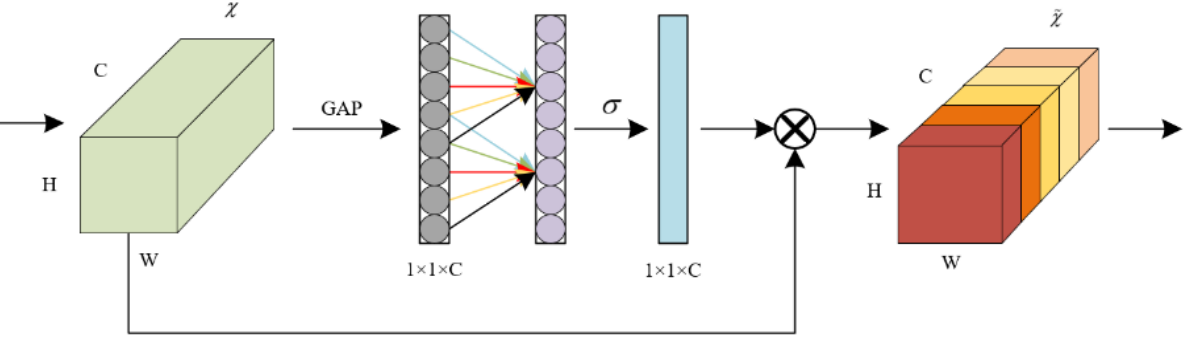
Figure 2. Diagram of ECA-Net module. For the aggregated features, ECA-Net generates channel weights by performing a fast 1D convolution of kernel size k, where k is proportional to the channel dimension.